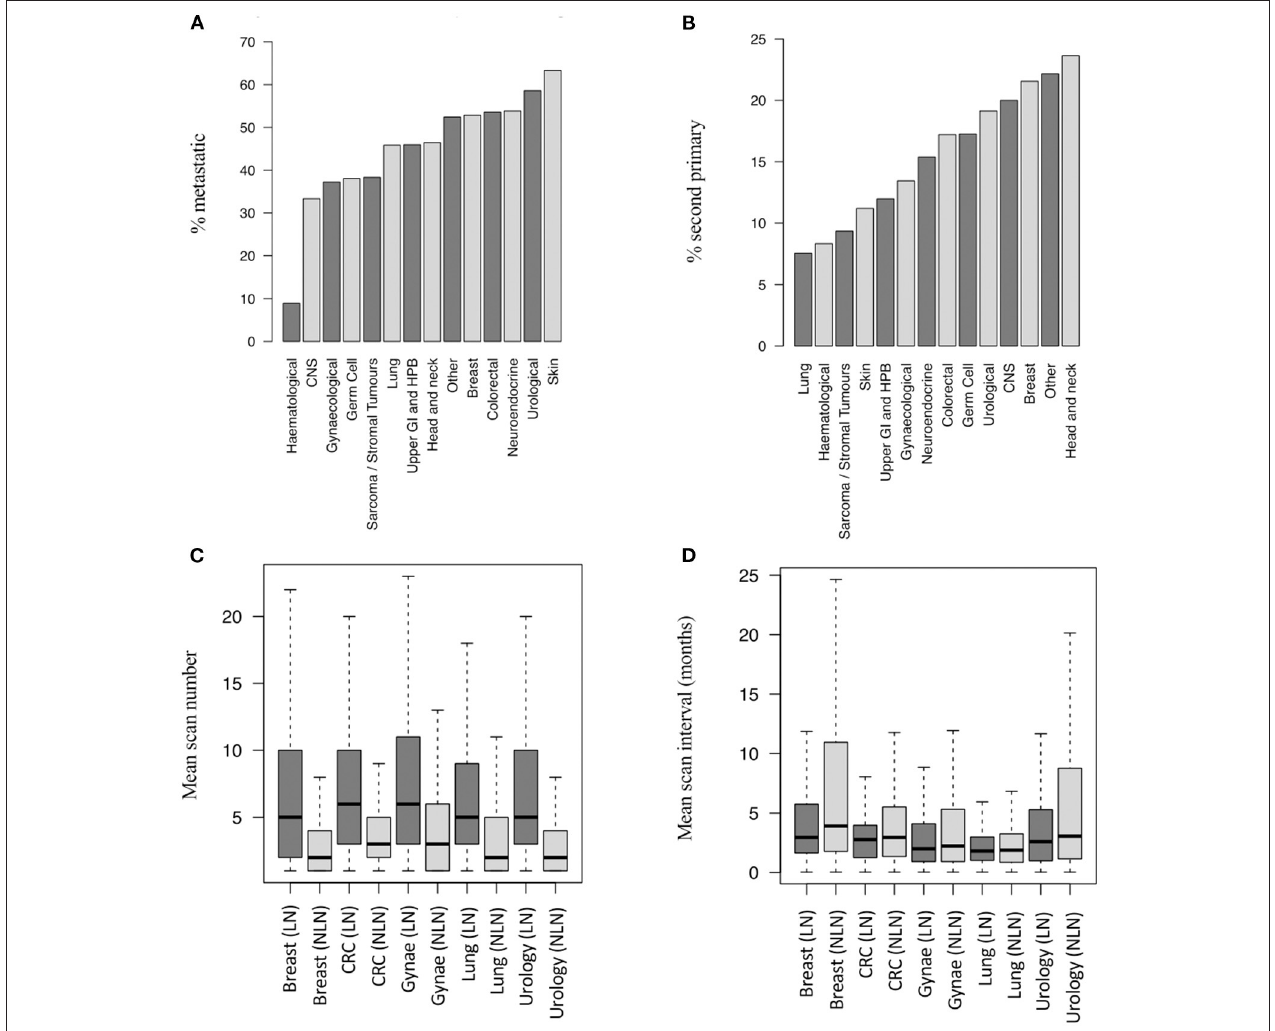
FIGURE 2 | Metastatic and second primary status in lung nodule patients. (A) Proportion of LN patients with metastatic disease by cancer group (14,586 patients). (B) Proportion of LN patients with SPs by cancer group (14,586 pts). (C) Number of post-baseline scans per patient by LN status and disease group (19,779 pts – top 5 disease groups by scan number shown). (D) Scan interval by LN status and disease group (19,779 pts - top 5 disease groups by scan number shown). SP, second primary; LN, lung nodule; NLN, no lung nodule; CNS, central nervous system; CRC, colorectal cancer; Gynae, gynaecological cancer; Haem, haematological cancer; N.E, neuro-endocrine cancer; UGI/HPB, upper gastro-intestinal/hepatobiliary cancer.